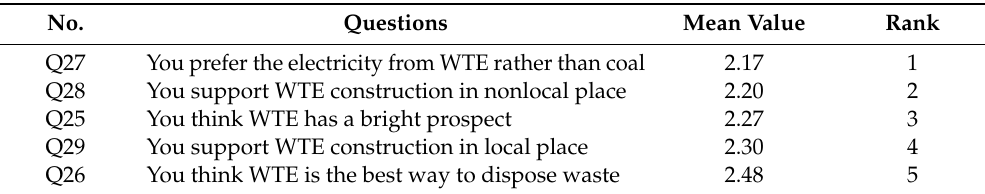
Table 8. The mean value of PAT towards WTE.